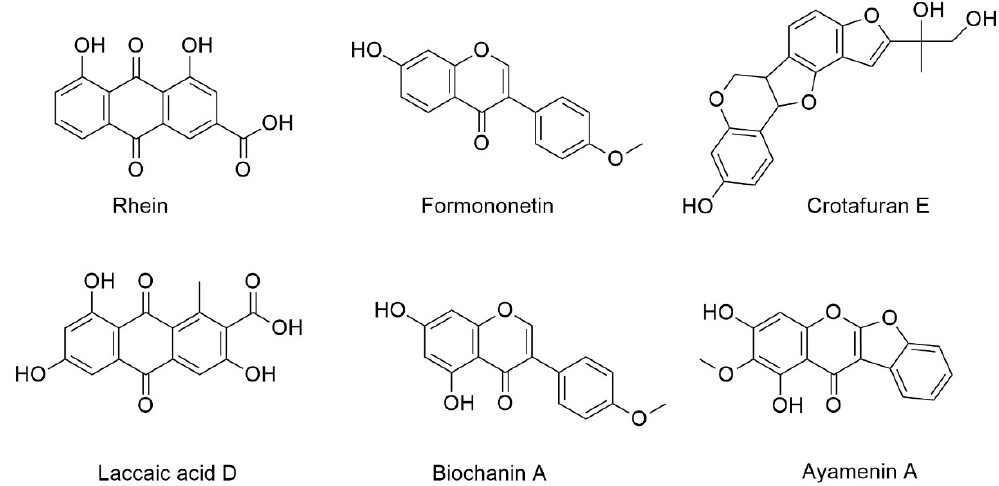
Figure 7. Putative identities and chemical structures of the six antibiotic metabolites of interest from C. cajan seeds.